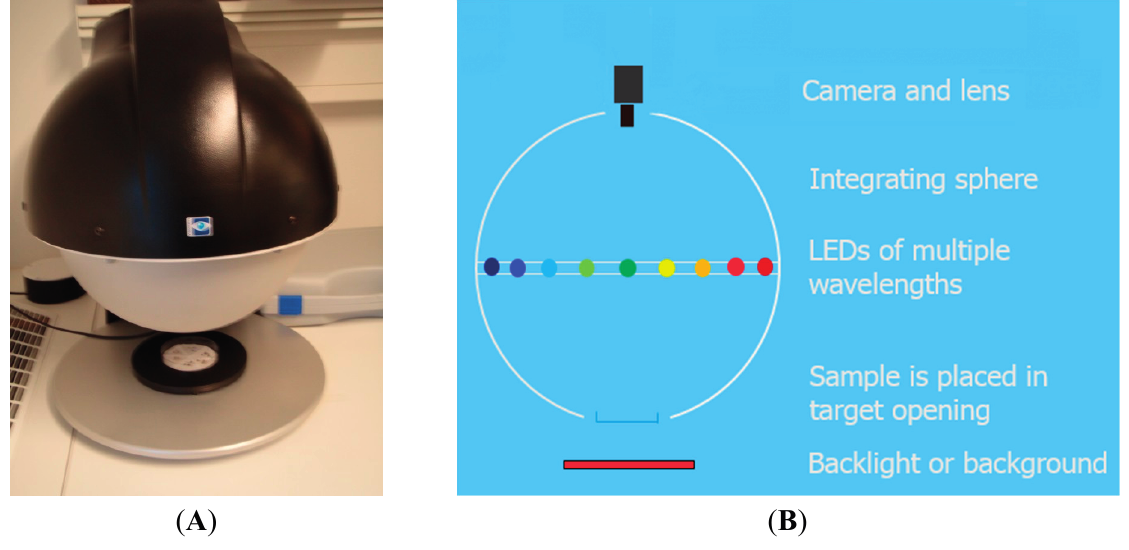
Figure 1. ( A ) Picture of the VideometerLab instrument and ( B ) is the outlines setup of the VideometerLab